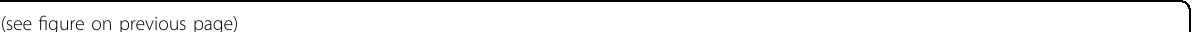
Fig. 1 The expression level of PRMT1 increased in RANKL-treated bone marrow-derived macrophages (BMDMs). a-d BMDMs were cultured with M-CSF (30 ng/ml) and RANKL (100 ng/ml) for the indicated time periods to induce differentiation into mature osteoclasts. a Cellular proteins were extracted and subjected to western blotting with the indicated antibodies. b Results of real-time PCR showing the mRNA expression level of PRMT1. The results were normalized to the expression level of β -actin. c Expression level of ADMA in a culture supernatant determined by ELISA. The results are expressed as the mean ± SD. * p < 0.05, ** p < 0.01, *** p < 0.001 vs. 0 d. d BMDMs were labeled with anti-PRMT1 and a fl uorescein isothiocyanate (FITC)-conjugated secondary antibody. F-actin ring formation was stained with Alexa Fluor 594-phalloidin and detected using a confocal microscope. The representative images are from at least three independent experiments. Scale bar: 5 μ